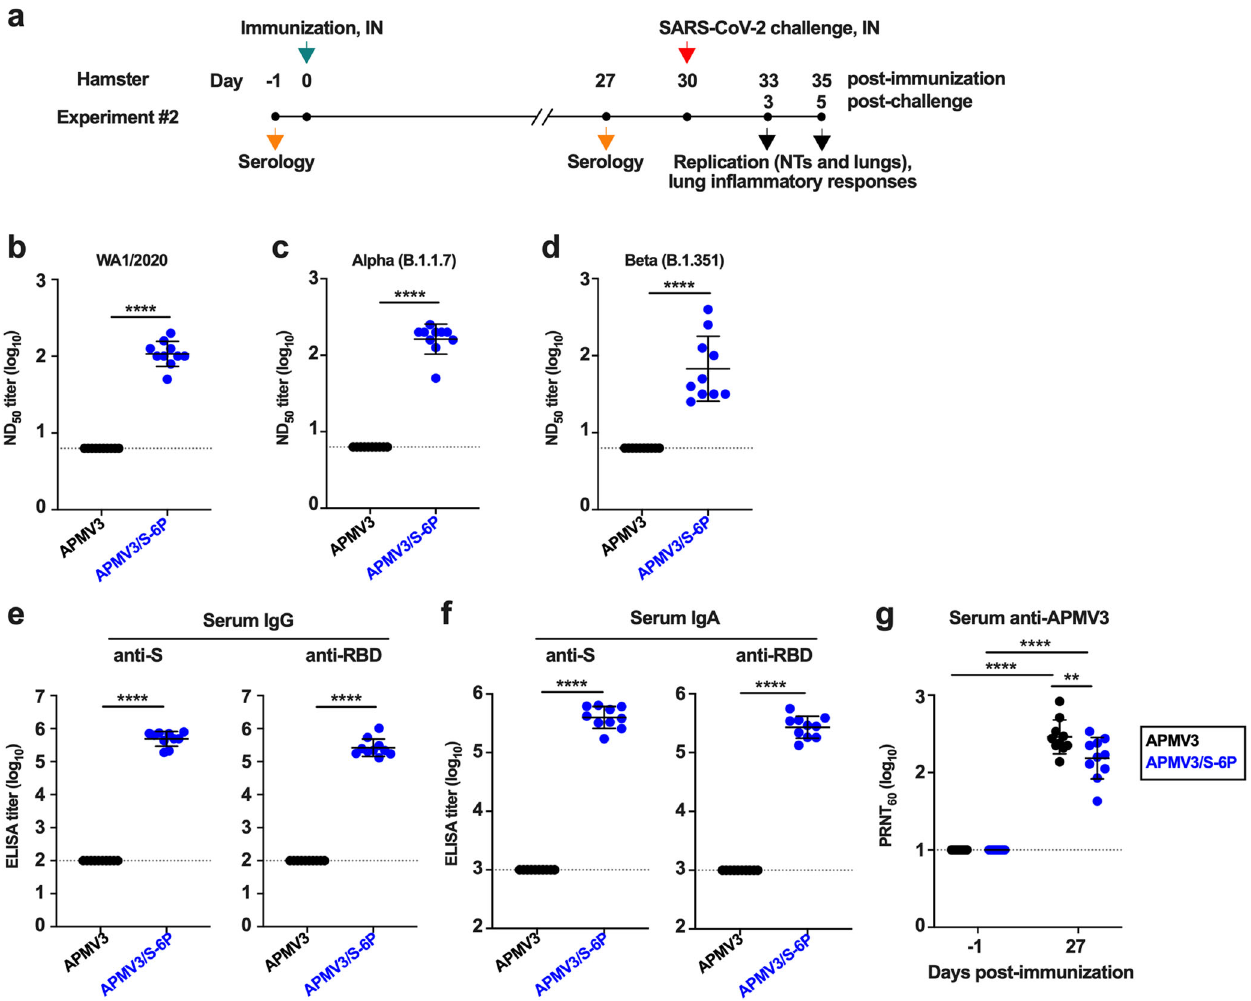
MD-HP01542/2021 (lineage B.1.351, Beta variant) ( d ). ND 50 titers are expressed in log 10 . The limit of detection, indicated by a dotted line, is 0.8 log 10 . e , f End-point ELISA titers expressed in log 10 for serum IgG ( e ) and IgA ( f ) to a secreted prefusion-stabilized form (aa 1 – 1208) of the S protein (left panels) or to a fragment of the S protein (aa 328 – 531) containing SARS-CoV-2 receptor-binding domain (RBD) (right panels). The limit of detection was 2 and 3 log 10 for IgG and IgA, respectively (dotted lines). g 60% plaque reduction neutralization titers (PRNT 60 ) of the sera collected on days -1 and 27 pi against APMV3. The limit of detection was 1 log 10 (dotted line). In each graph, the means and SD